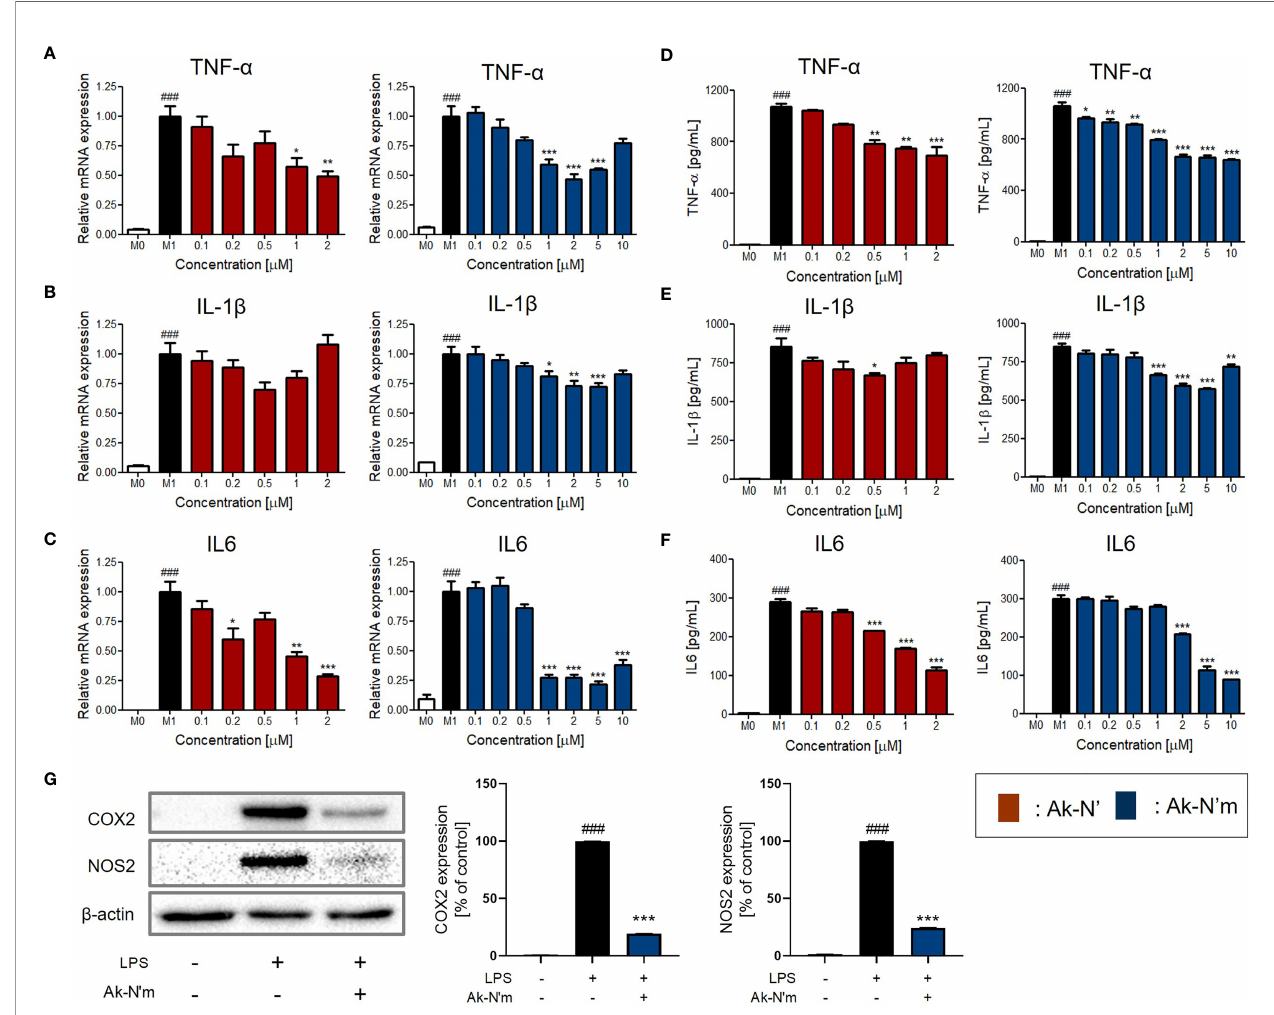
FIGURE 6 | Inhibition of pro-in fl ammatory mediators by Ak-N ’ and Ak-N ’ m on LPS-stimulated macrophages. Treatment of Ak-N ’ (red) and Ak-N ’ m (blue) was evaluated of the changes on mRNA expression level. (A) TNF- a , (B) IL-1 b , and (C) IL6 were measured by qRT-PCR upon co-treatment of LPS (1 m g/mL) and the peptide. The secreted cytokine levels in the cell supernatant were measured by ELISA after treatment the peptide with or without LPS. The levels of (D) TNF- a , (E) IL-1 b , and (F) IL6 decreased when peptides were co-treated compared to the single treatment of LPS. (G) The protein level of COX2 and NOS2 decreased when simultaneously treated with LPS and 2 m M Ak-N ’ m for 24h. Data are presented as mean ± SEM. ### p < 0.001 compared to the control group; *p < 0.05, **p < 0.01, and ***p < 0.001 compared to the LPS-stimulated